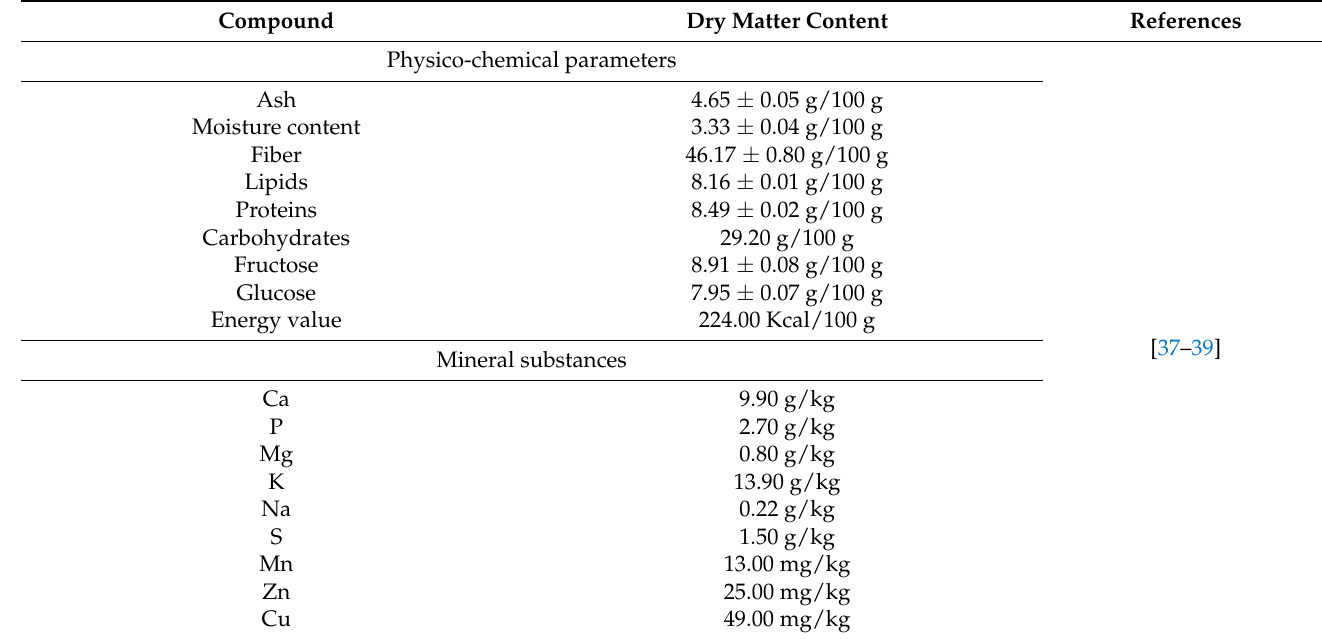
Table 1. Physico-chemical composition of grape pomace ( Vitis vinifera L.).